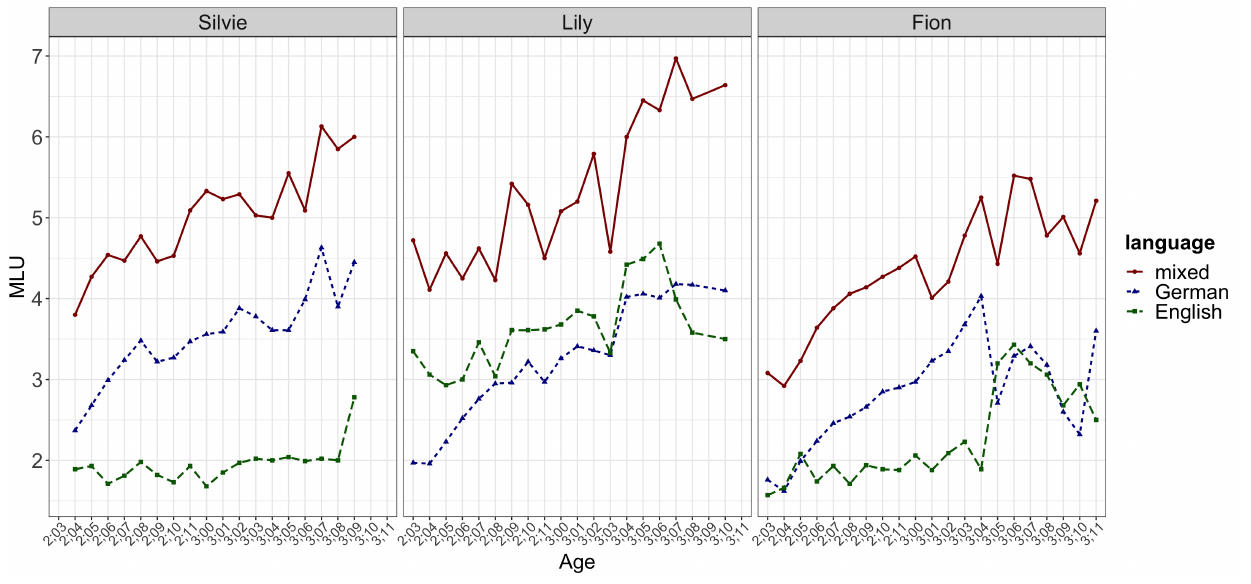
Figure 2. MLU in German-English bilingual children across